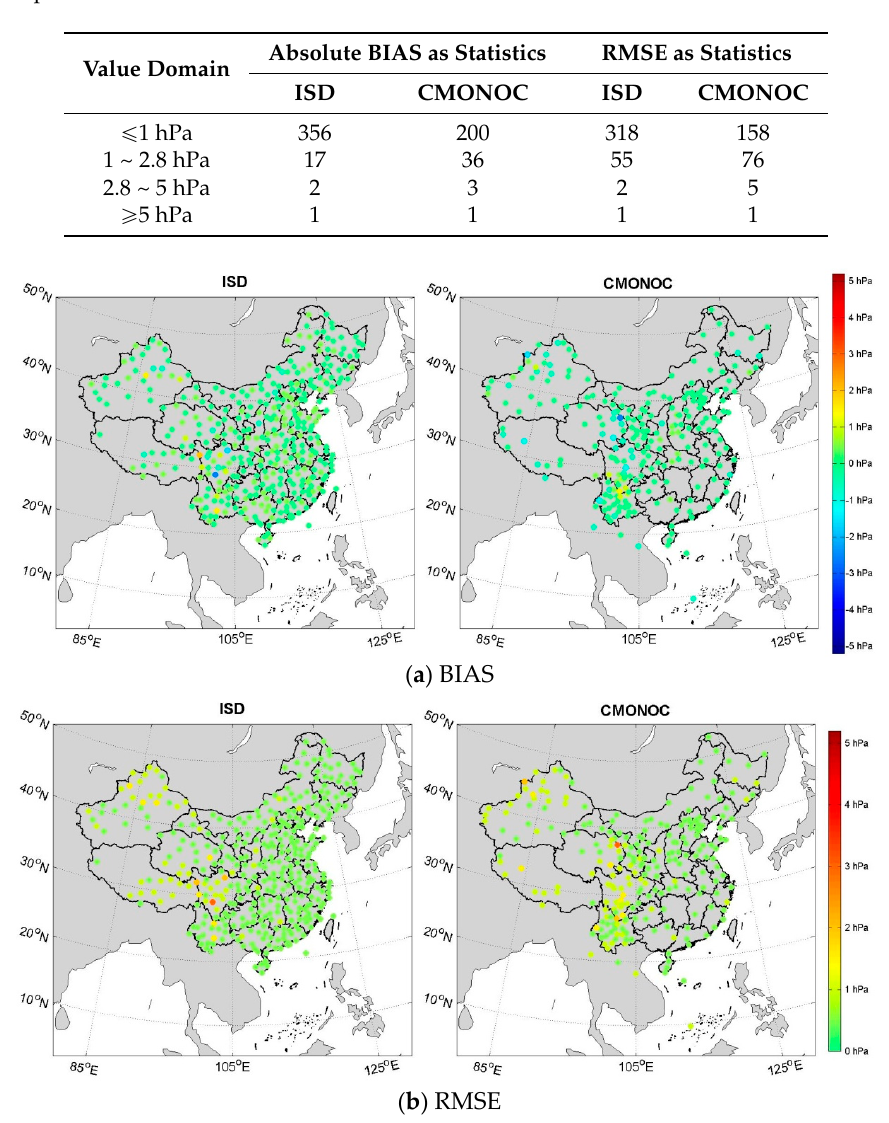
Figure 4. ( a ) BIAS and ( b ) RMSE between interpolated and measured surface pressure of stations from ISD and CMONOC.